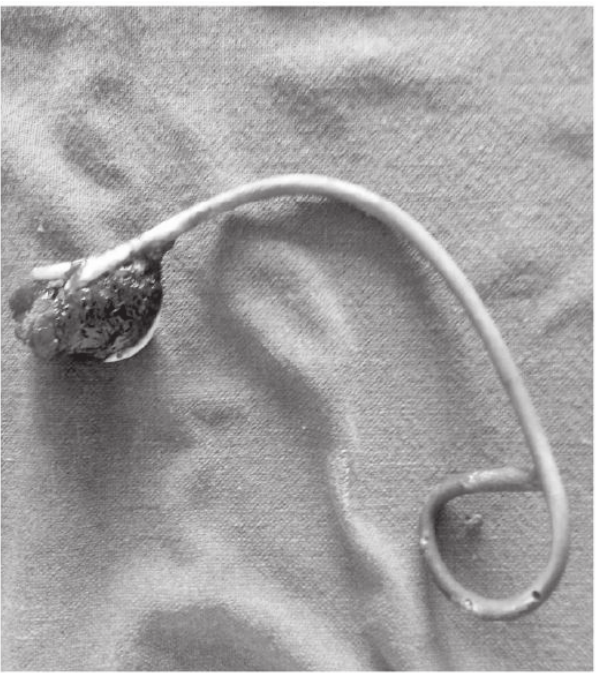
Figure 2: Stentolith after removal from common bile